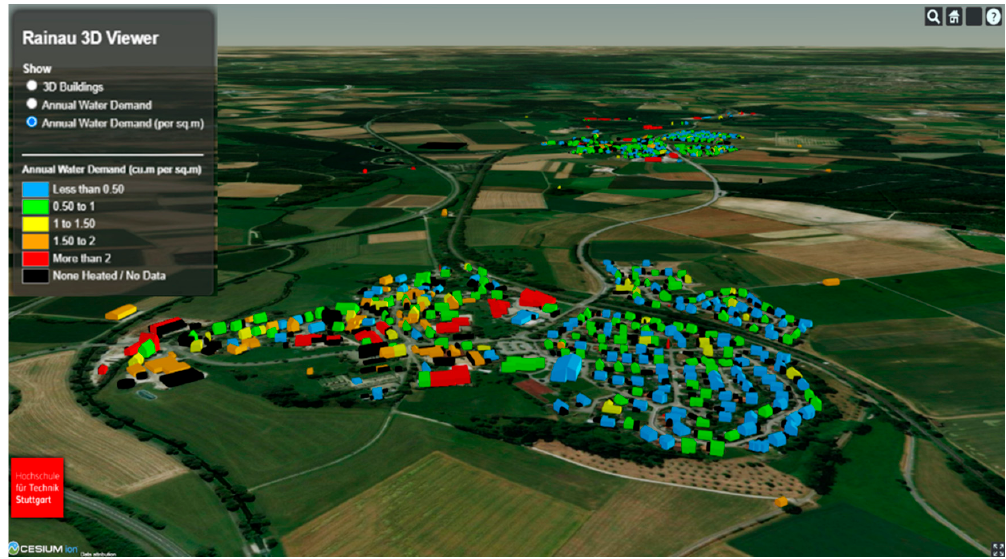
Figure 7. Visualization of water demand per square meter per building in m 3 / m 2 in Rainau with CityGML and satellite map.